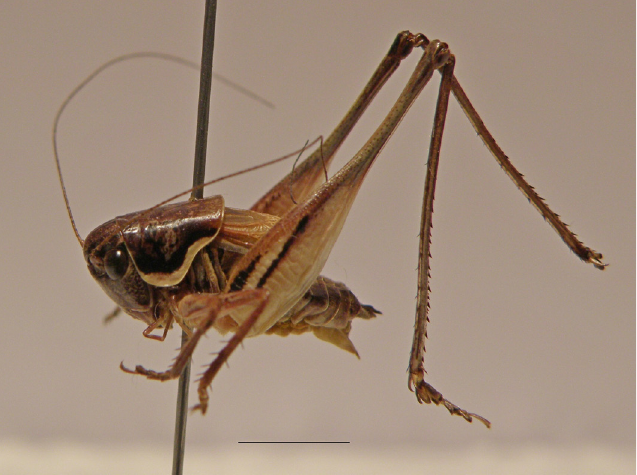
Figure 3. Anterastes serbicus , lateral view (scale bar: